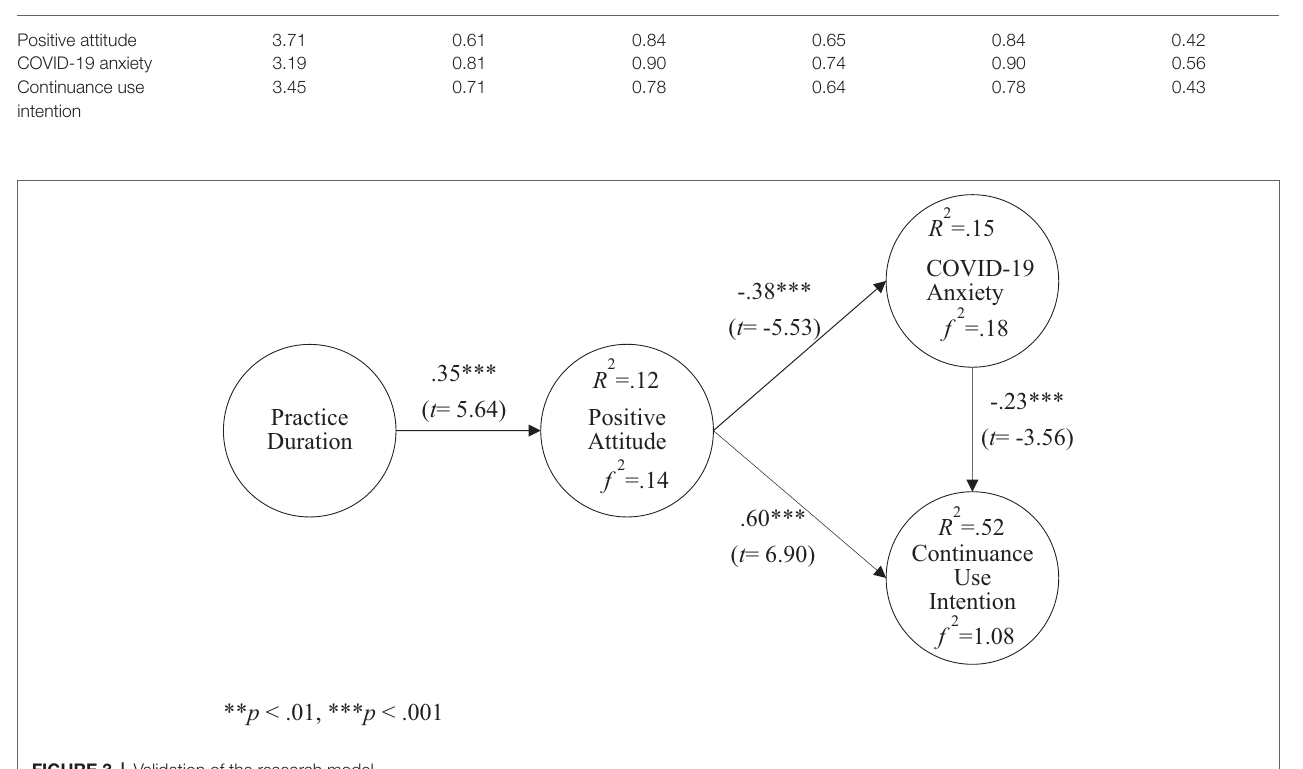
FIGURE 3 | Validation of the research model.